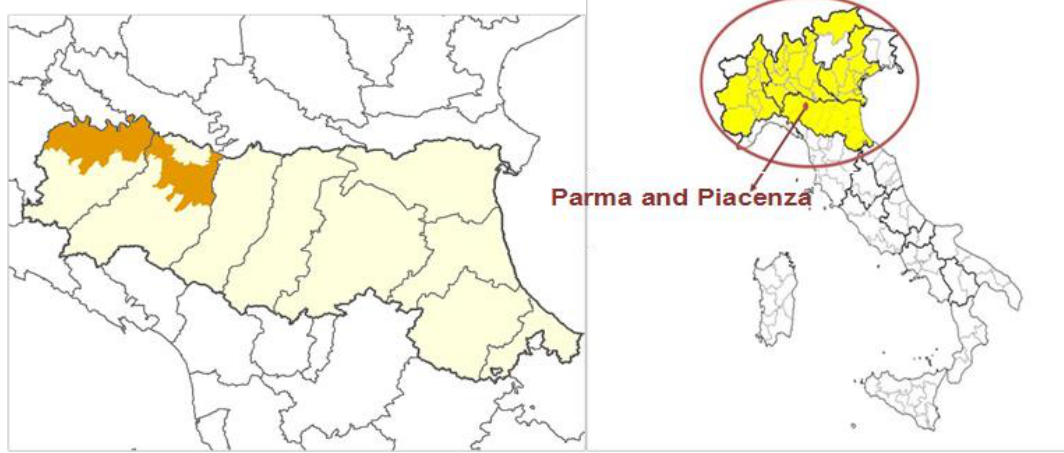
Figure 1. The case study area (in orange) and the supply chain area (in yellow).